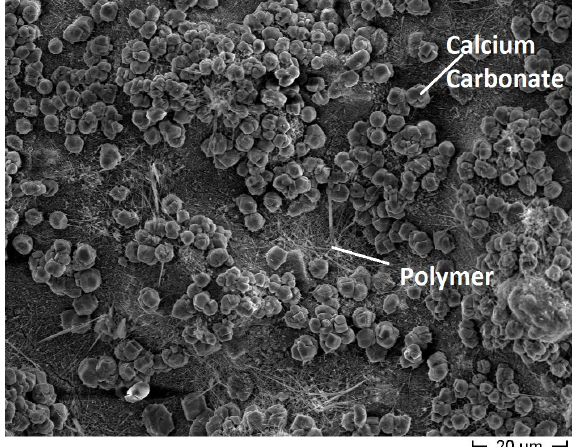
Figure 5. FE-SEM micrograph of the interior surface of the cementitious big hollow tube without coating (recipe for maccherone No. 5). The surface is homogeneous and free from